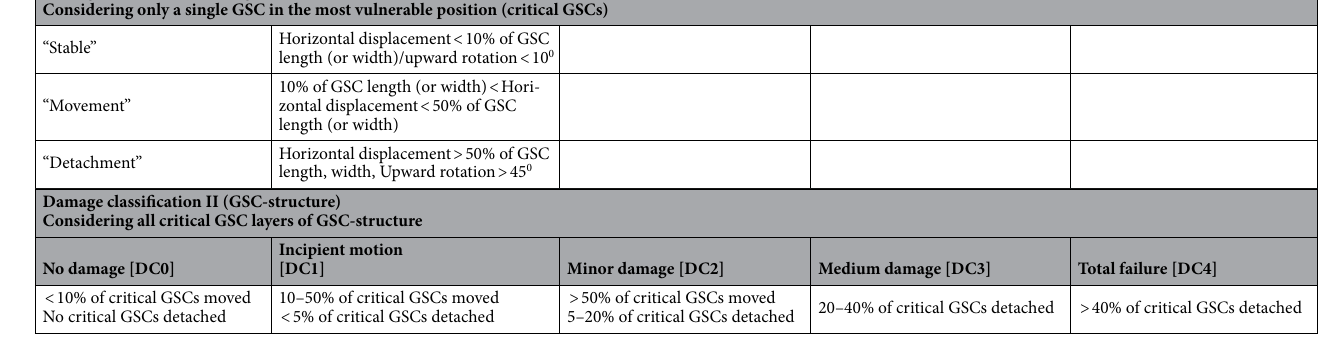
Table 4. Damage classification 54 .